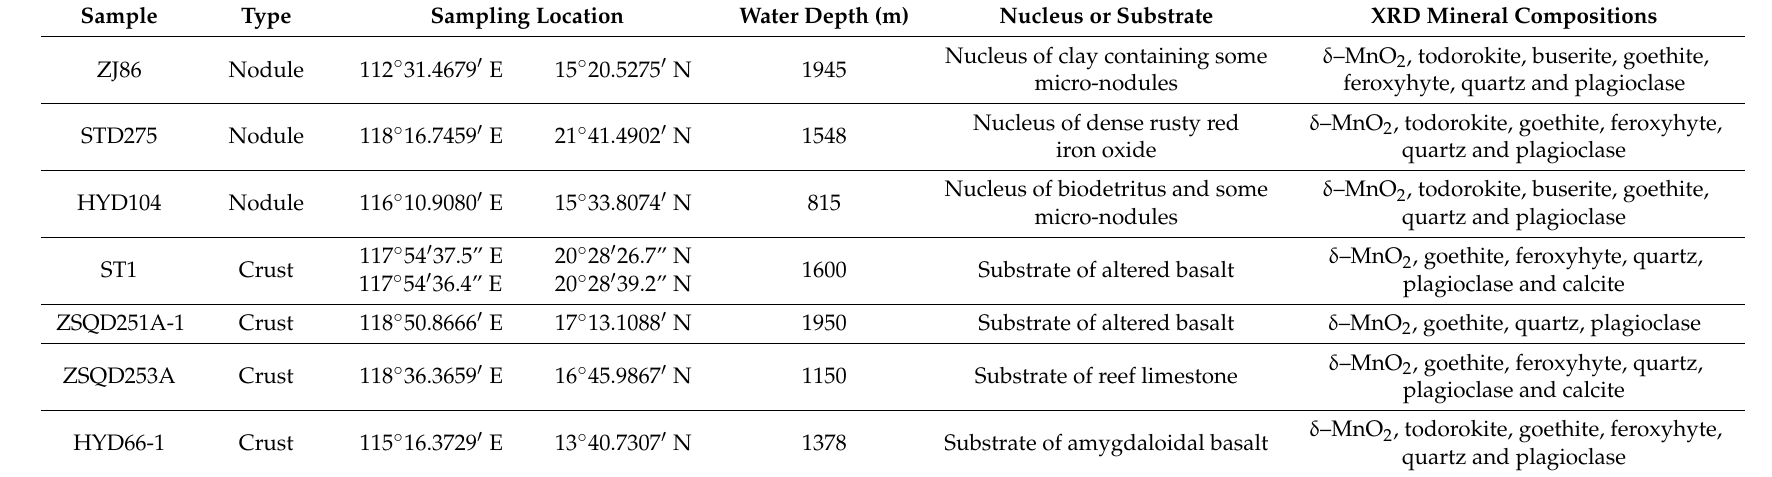
Table 1. Sample descriptions and mineralogy of the Fe-Mn polymetallic crusts and nodules from the South China